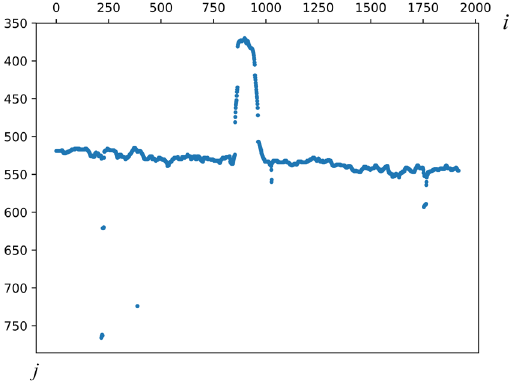
Figure 8. Scatter plot of the first bright point in each column. The first bright point in each image’s column is selected through the above